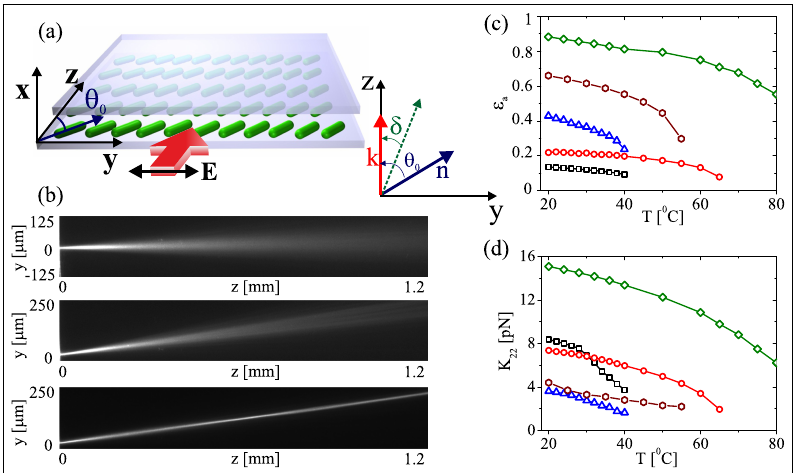
Figure 1. ( a ) NLC sample geometry. ( b ) Typical linear and nonlinear propagation of light beams. Top: ordinary-wave diffracting beam. Center: extraordinary-wave beam at low power, undergoing diffraction. Bottom: extraordinary-wave beam at high power, undergoing self-confinement. Measured ( c ) dielectric and ( d ) elastic constant K 22 versus temperature in five NLC mixtures: 1110 (black squares), 903 (red circles), 6CHBT (blue triangles), E7 (brown hexagons), 2007 (green